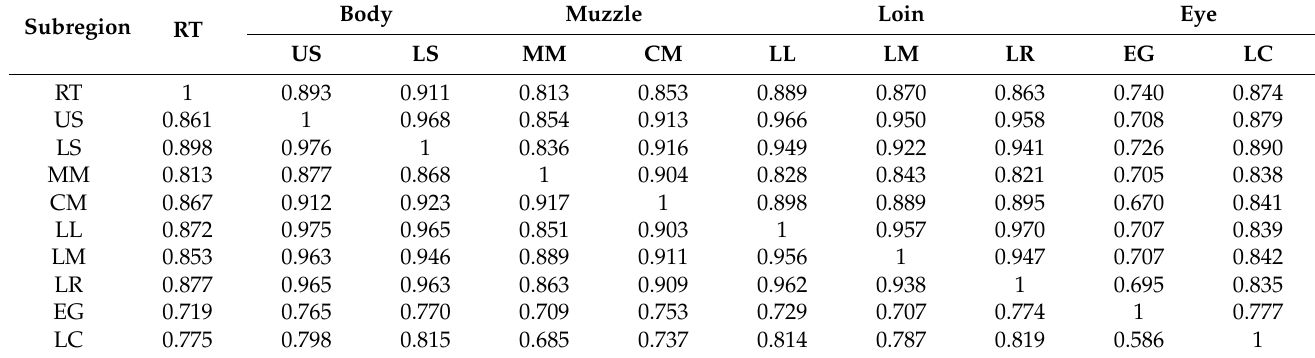
Table 3. Pearson correlation coefficients ( p < 0.0001) estimated between the maximum temperature of each subregion of body surface obtained by infrared thermography and rectal temperature (RT) in males (top of the table) and females (bottom of the